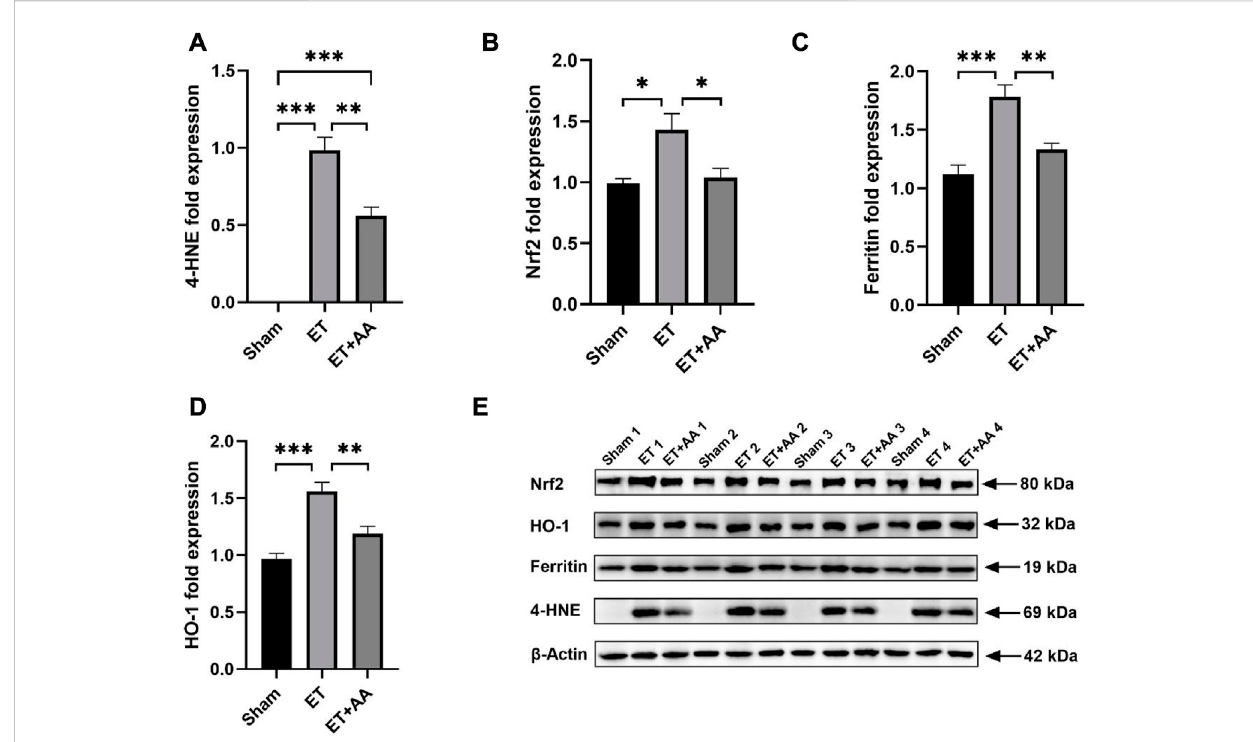
FIGURE 11 Effect of ascorbic acid on alleviating oxidative stress in the kidneys of guinea pigs. (A – D) Graphic representation of the fold expressions of 4-HNE, Nrf2, ferritin, and HO-1, respectively. (E) Image of the Western blotting assay. Values are expressed as mean ± SEM, n =